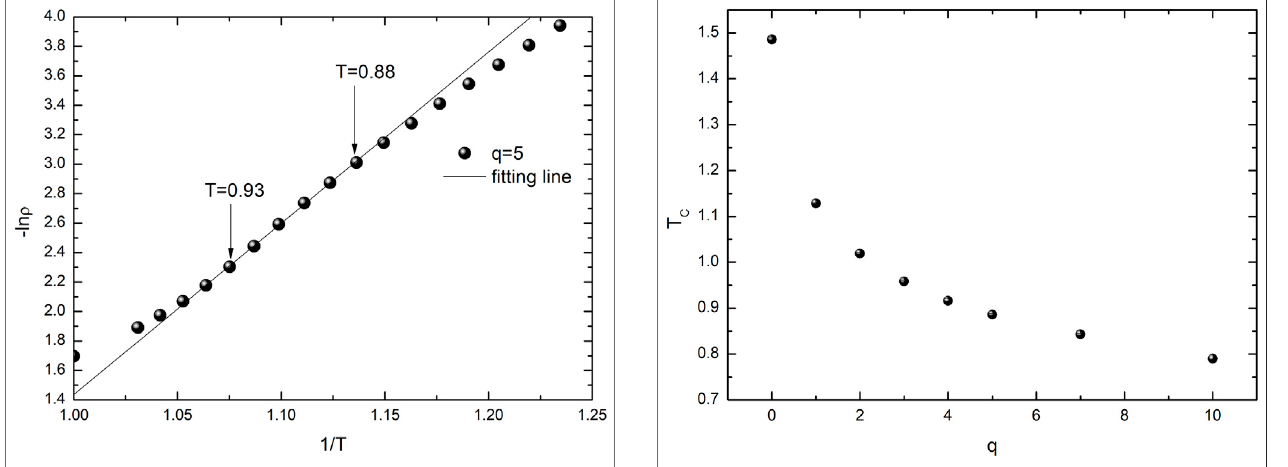
FIGURE 7 | The critical temperature for different q